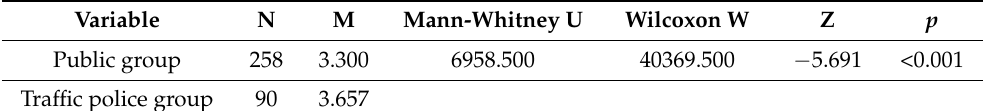
Table 9. Differences in attitudes toward FRT between the public and traffic